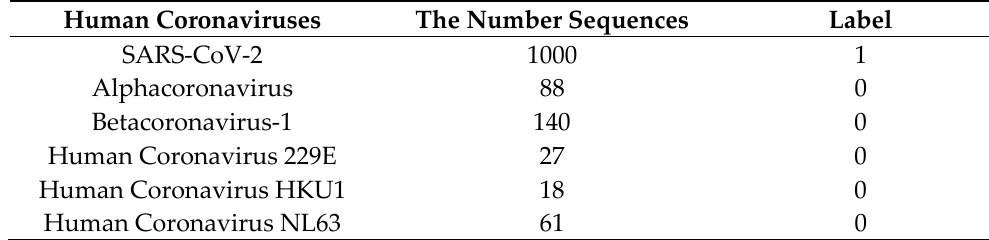
Table 1. Sequence properties. The 2019 Novel Coronavirus Resource (2019nCoVR) naming con- vention was